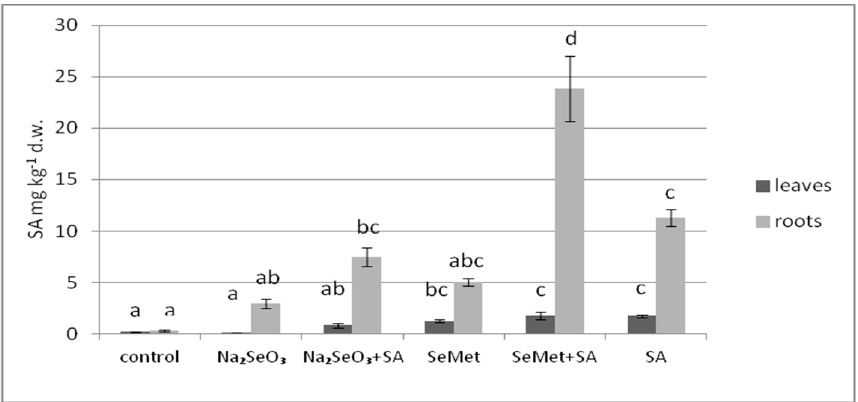
Figure 5. E ff ect of selenium form and salicylic acid application on the content of salicylic acid in the leaves and roots of lettuce. Means followed by di ff erent letters indicate significant di ff erences ( p < 0.05). The bars indicate standard error ( n =